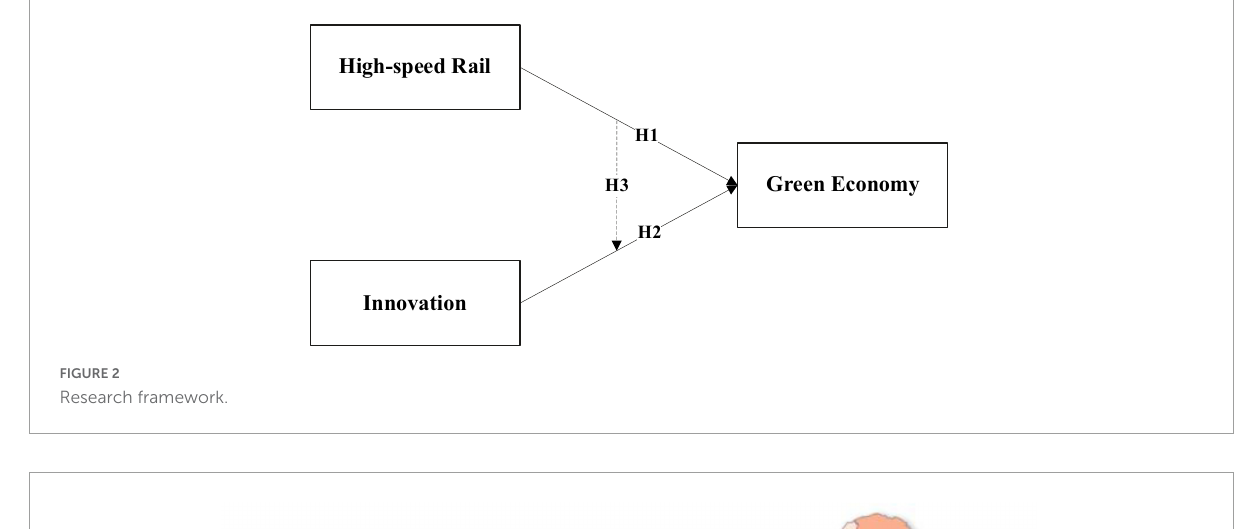
FIGURE2 Research framework.